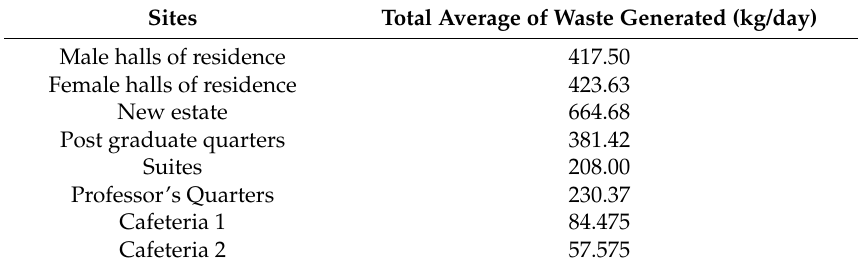
Table 8. Total average weight of waste generated in selected sites.